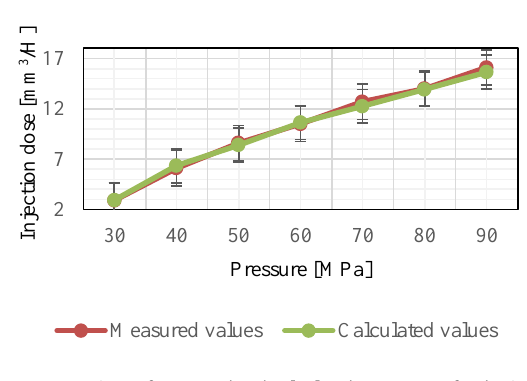
Fig. 6. Comparison of measured and calculated parameters for the injector control time of 525 µs